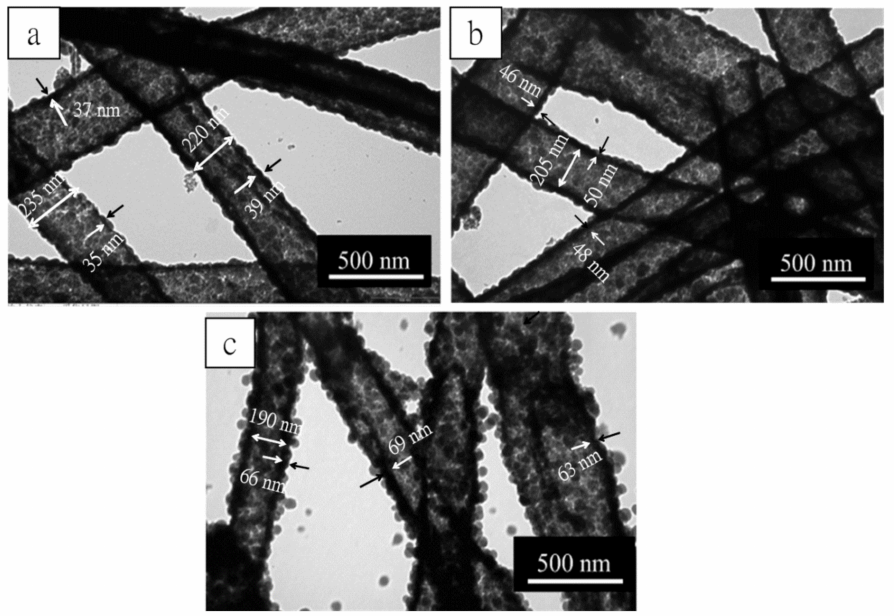
Figure 5. TEM images of ( a ) MSNTs-1, ( b ) MSNTs-2, ( c ) MSNTs-3, corresponding tetraethoxysilane (TEOS) additions from 3, 5 to 7 mL,